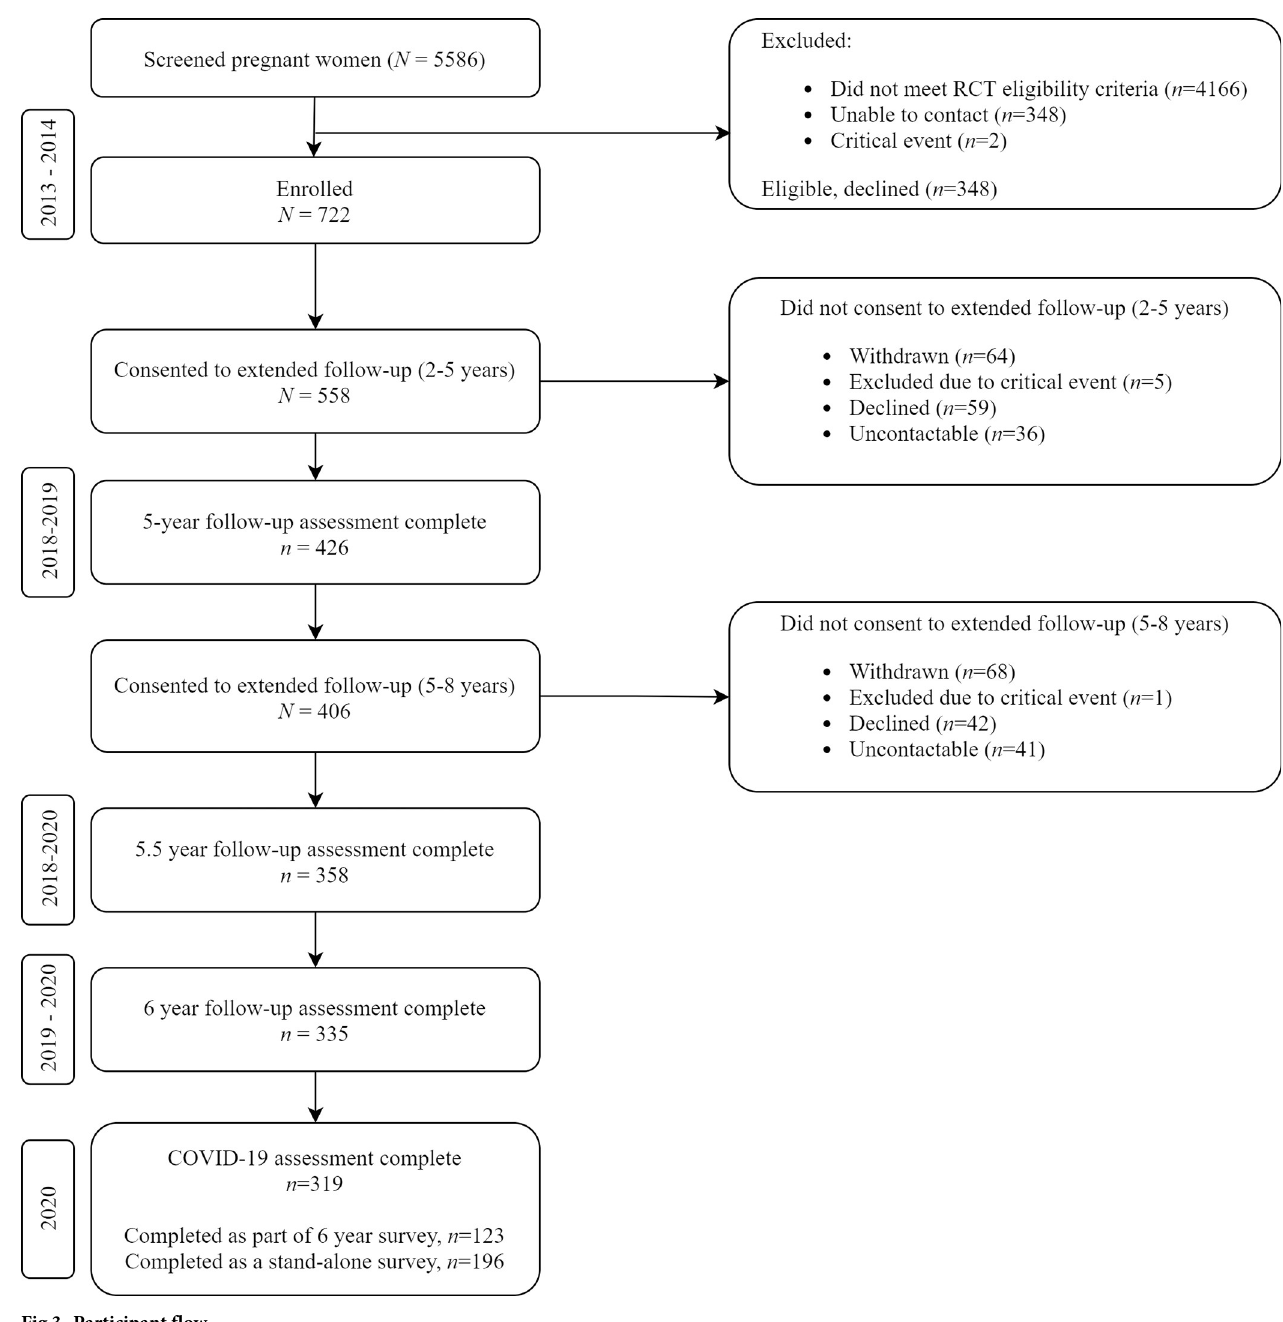
Fig 3. Participant